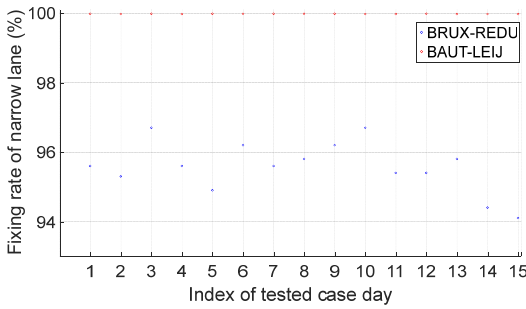
Figure 20. Fixing rate of narrow ‐ lane ambiguity.